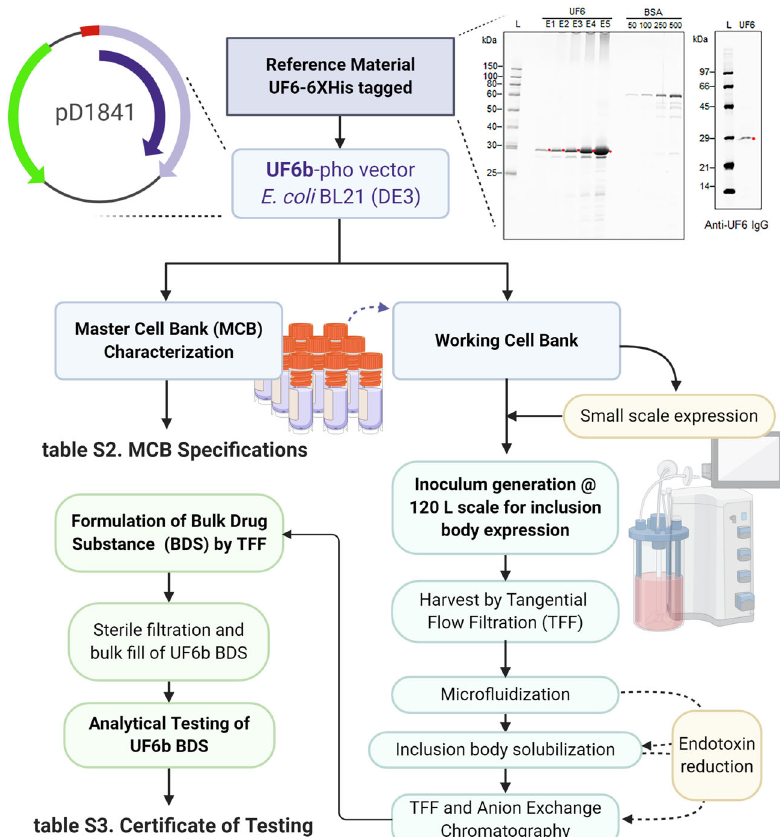
Fig. 2 Process fl ow diagram for UF6b manufacture. (Top right) UF6 antigen produced by CellFree Sciences in the wheat-germ cell-free system, which was recognized as a 29 kDa band by anti-UF6 antibody, was used as reference material by Ology Bioservices for process development. (Top left) E.coli BL21 (DE3) was transformed with UF6b-phopD1841 to produce a Master Cell Bank (MCB) expressing the UF6b, His-tag-free antigen. Using a lot from the MCB, pilot small-scale expression was followed by replicate 120-L scale runs with the goal of high- yield production of UF6b in inclusion bodies to aid in the puri fi cation steps to reduce endotoxin. In-process UF6b was used for all immunological and functional assays. Bulk Drug Substance was further characterized and observed to yield low endotoxin levels. kDa, kilodalton. BSA, bovine serum albumin standards. See Supplementary Table 2 and Supplementary Table 3 for more